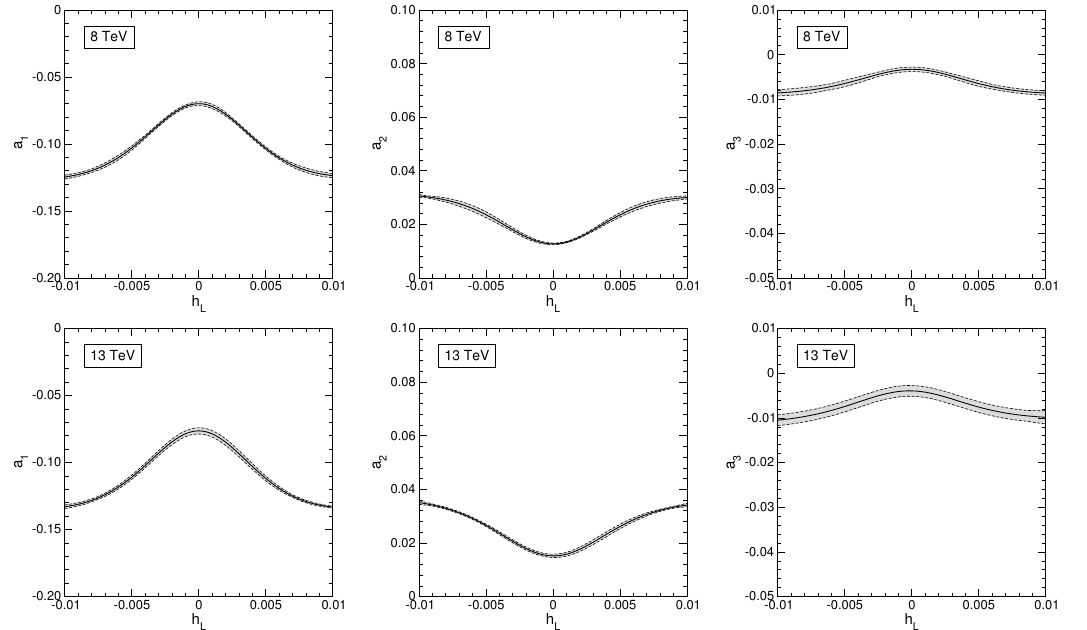
Figure 5 . Dependence of the (cid:12)rst Fourier coe(cid:14)cients in (2.1) on a possible top tbW anomalous coupling h L in eq. (4.3), for CM energies of 8 TeV and 13